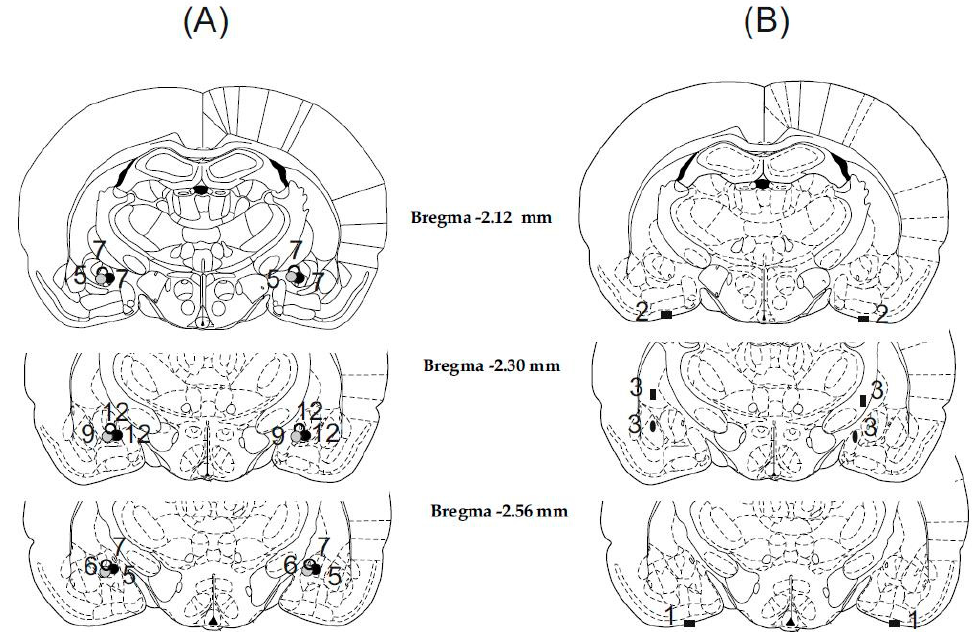
Figure 1. Illustration of reconstructed injection sites. Correct bilateral injection placements are indicated by closed gray and black circles in the CeA in panel ( A ) ( n = 70). Incorrect injection placements are indicated in panel ( B ) ( n = 9). Brain structure diagrams of coronal sections are adapted from the stereotaxic atlas of Paxinos and Watson. The numbers refer to anterior–posterior distances from the bregma in mm. Identical symbols in panel ( B ) indicate coherent injection sites of bilateral injections. Numbers above marked sites in panels ( A , B ) indicate numbers of animals.